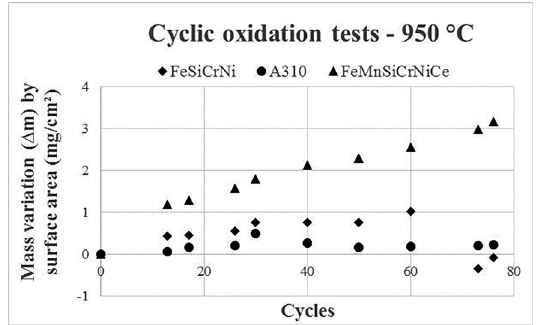
Figure 2. Mass variation by superficial area versus number of cycles in cyclic oxidation test at 950 ºC.